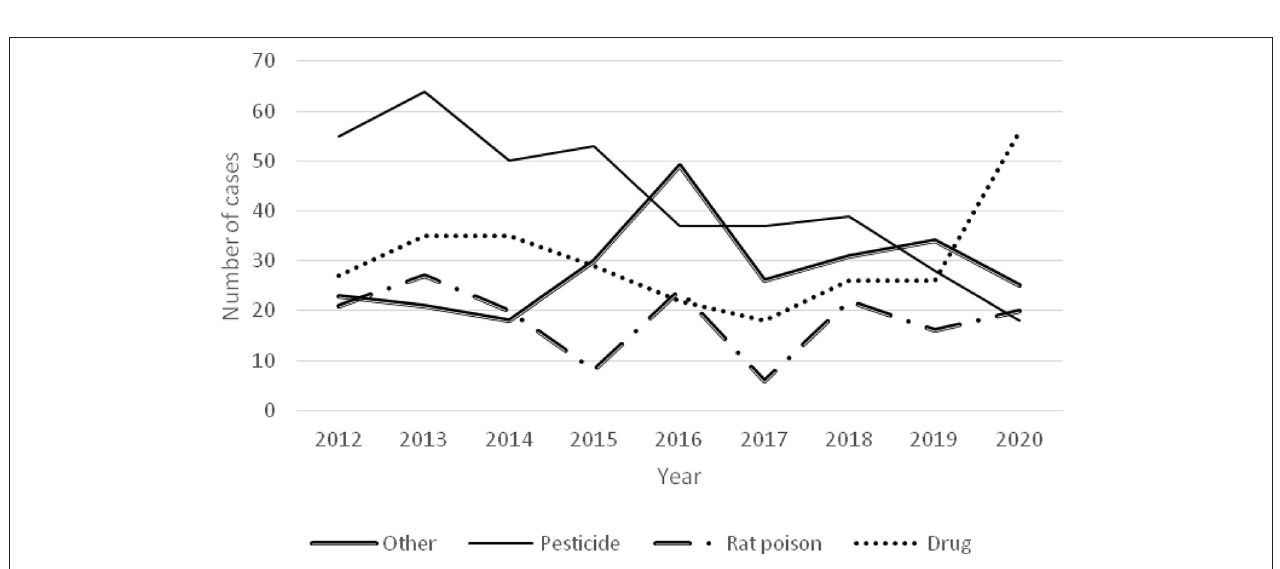
FIGURE 4 | Time-varying curve of each poisoned substance and number of poisoned children in rural and urban